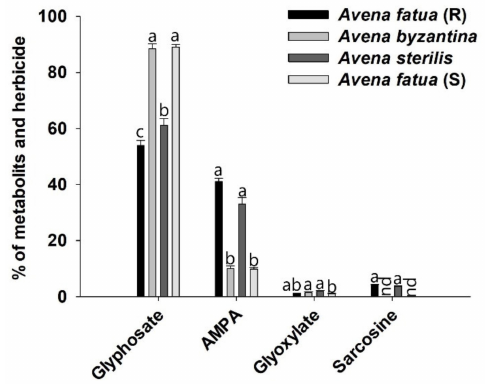
Figure 7. Glyphosate metabolism given as a percentage of total glyphosate and the metabolites in five Avena spp. treated with 360 g ae ha − 1 and harvested 96 HAT. Nd = non detected. Different letters correspond to Tukey’s test and mean